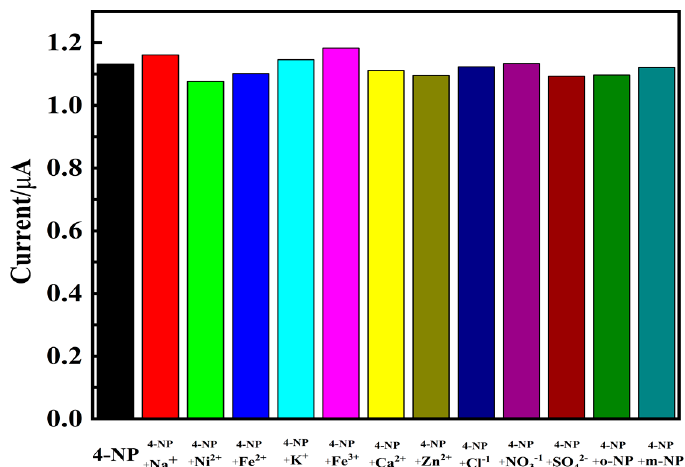
Figure 10. DPV response of 4-NP in 0.1 mol · L − 1 PBS (pH = 6.0) at CLR-PC/GCE for different interference compounds.